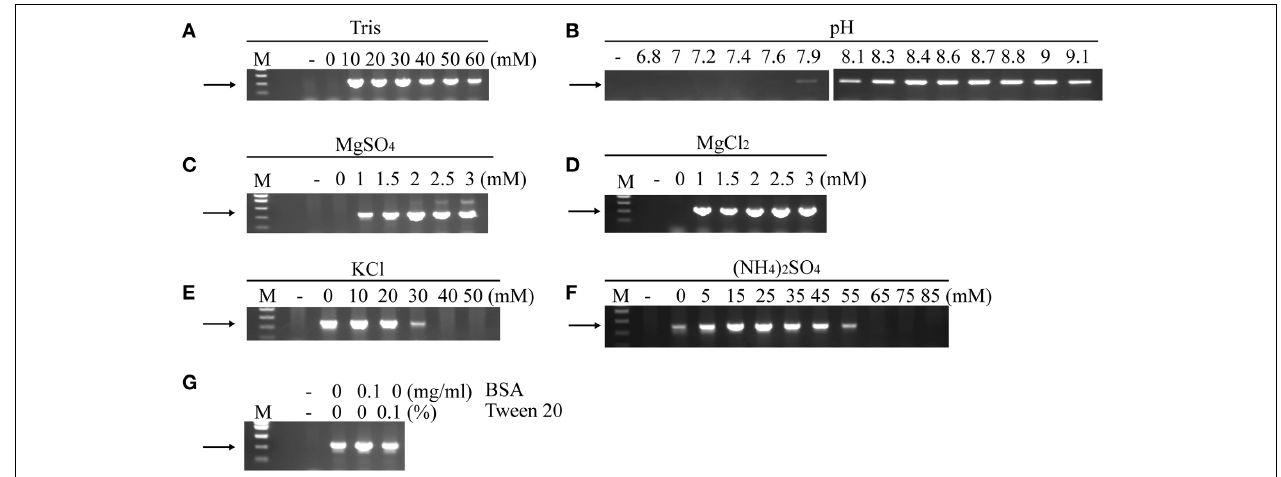
1min at 58 ◦ C, 2min at 72 ◦ C) × 30; (5min at 72 ◦ C) × 1. Effect of varying the Tris concentration (A) , pH (B) , MgSO 4 (C) , MgCl 2 (D) , KCl (E) , (NH 4 ) 2 SO 4 (F) . The absence or presence of BSA and Tween 20 are shown in (G) . Molecular weight markers (M) are SmartLadder SF from Eurogentec. (–) denotes negative control without Pab-polD. The arrow indicates the specific 0.5kb band.